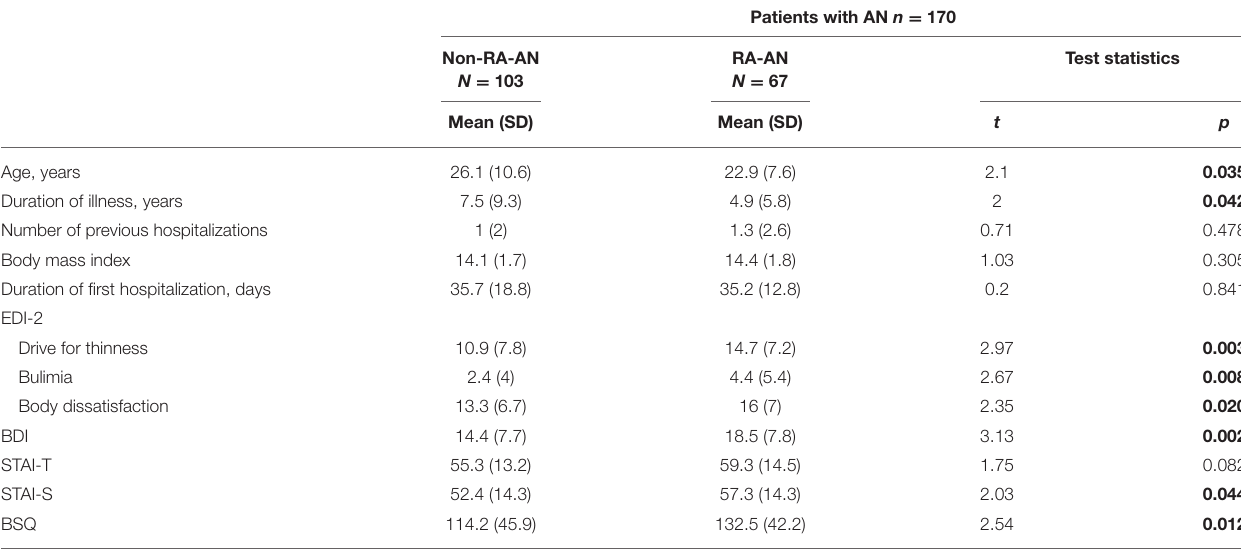
TABLE 1 | Differences in clinical variables during baseline hospitalization between readmitted (RA-AN) and non-readmitted (non-RA-AN) patients with anorexia nervosa (AN).